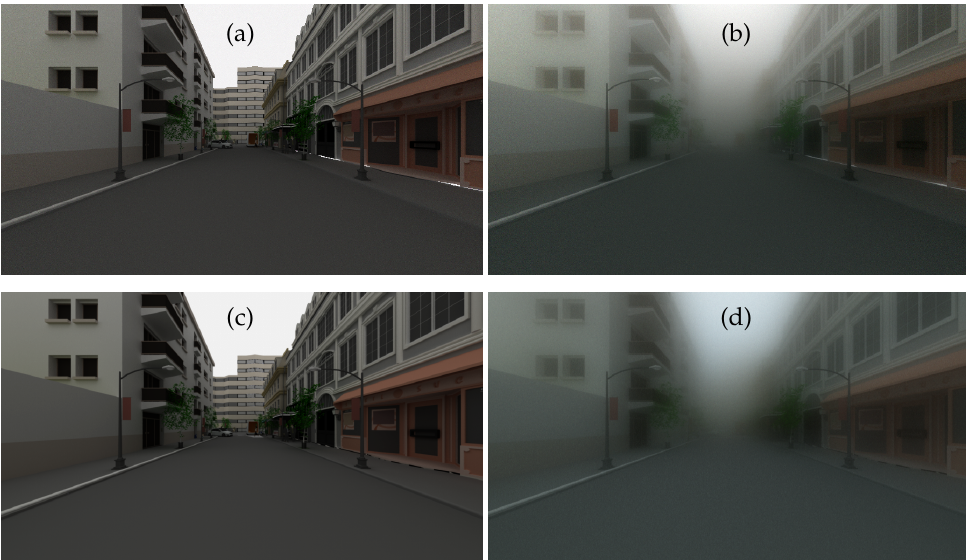
Figure 5. Simulated images for the intra-urban scene in day conditions by the SWEET simulator without fog ( a ) and with fog (MOR = 20 m, ( b )) and by the Mitsuba renderer without fog ( c ) and with fog (MOR = 20 m, ( d